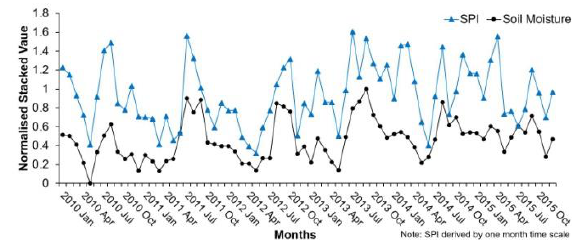
Figure 7. Monthly temporal variation of soil moisture against